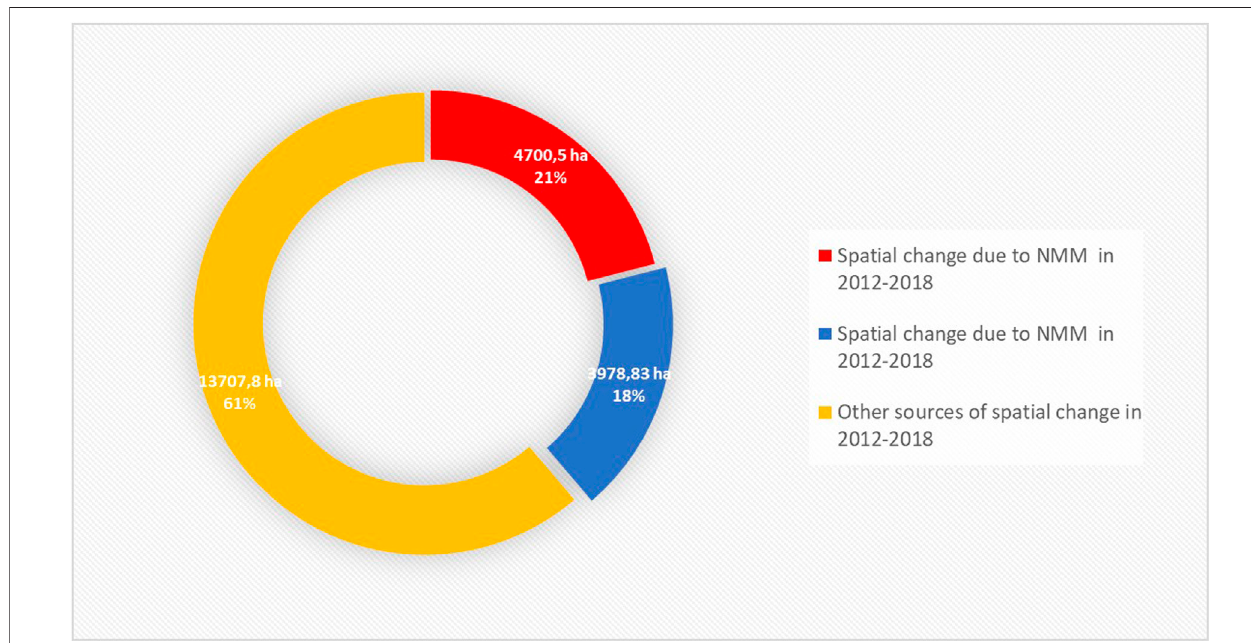
FIGURE 4 | Spatial change ratios between 2012 – 2018 period and sources of